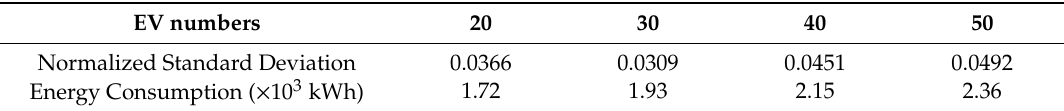
Table 2. Statistic information of the load profile and the energy consumption with EV numbers of 20, 30, 40, and 50.